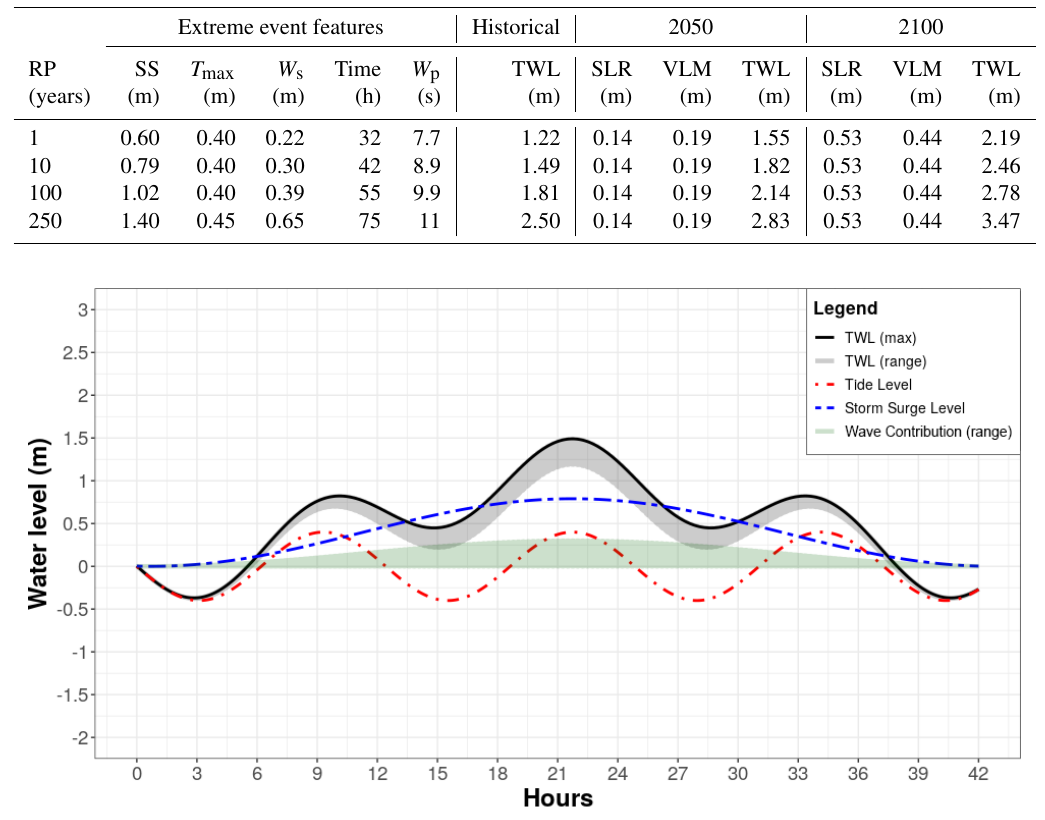
Figure 4. Design of dynamic ESL scenario corresponding to RP 10 years under historical MSL conditions. The maximum TWL is shown as the solid black line, while the TWL range at any given time is shown as the shaded grey area. The components of the nearshore TWL are the tide level (dashed red line), the storm surge level (dashed blue line) and the wave contribution (green-shaded area). Wave contribution is represented as a shaded area due to its high frequency (period of 8.9s). In this scenario (RP 10) the maximum storm surge level is 0.79m, the maximum high tide is 0.40m and the wave contribution ranges from 0.00 to 0.30m, with a wave period of 8.9s. At the peak of the event, these conditions produce a maximum TWL of